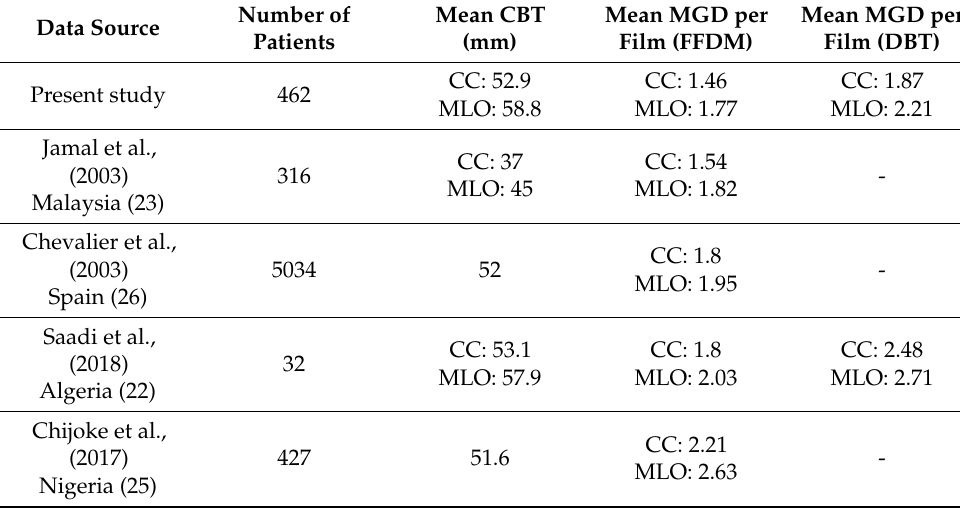
Table 5. Comparison with other